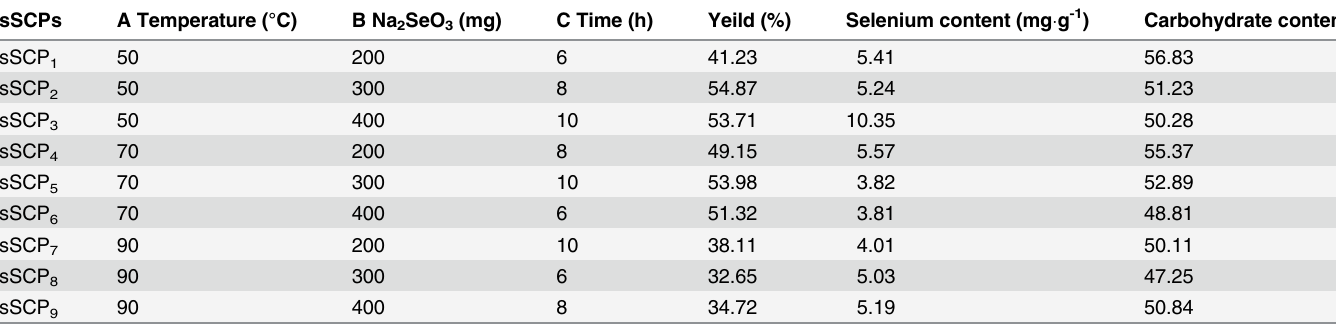
Table 1. The modification conditions, yields, contents of selenium and carbohydrate of sSCPs. sSCPs A Temperature